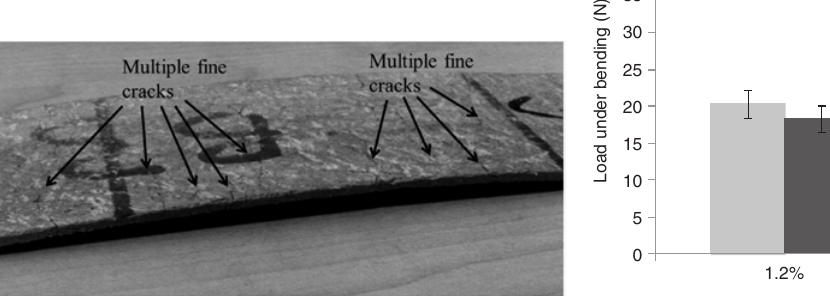
Figure 7 Sample with multiple fine